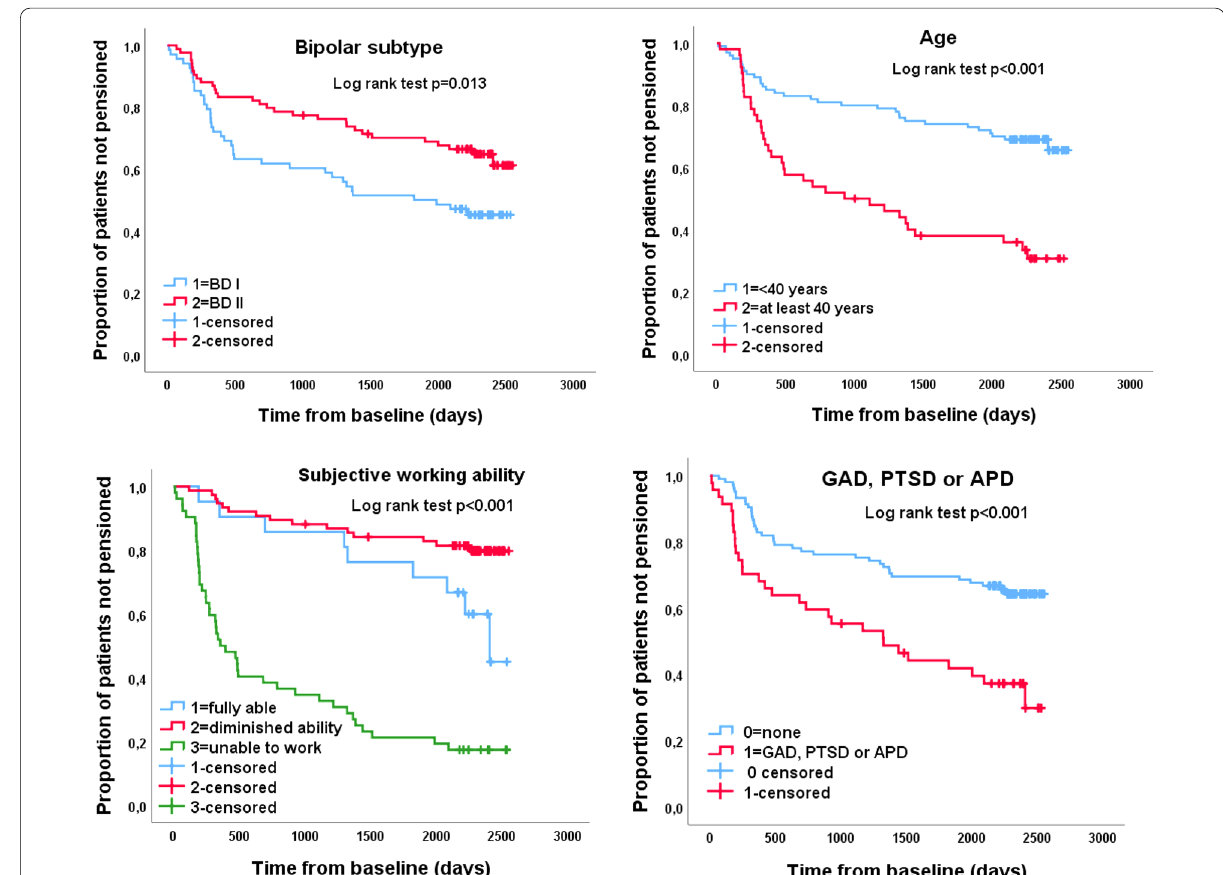
Fig. 1 Kaplan–Meier survival curves of proportion of patients granted disability pension during 6-year follow-up of 152 patients not receiving pension at